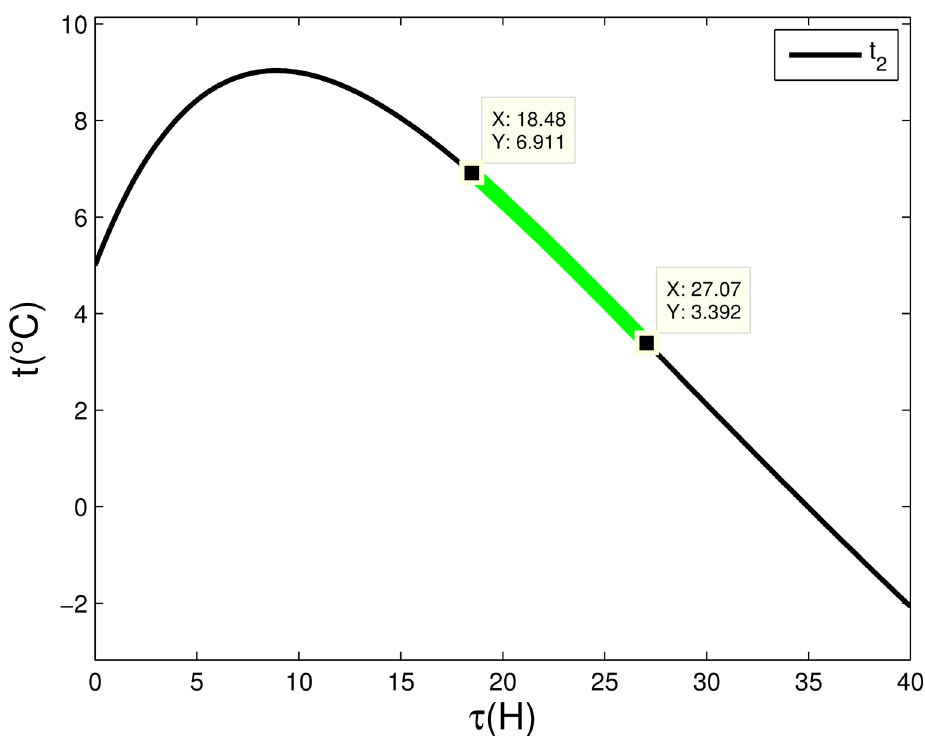
Fig 10. Temperature changes with time. Green line represents an appropriate time interval of arrival.